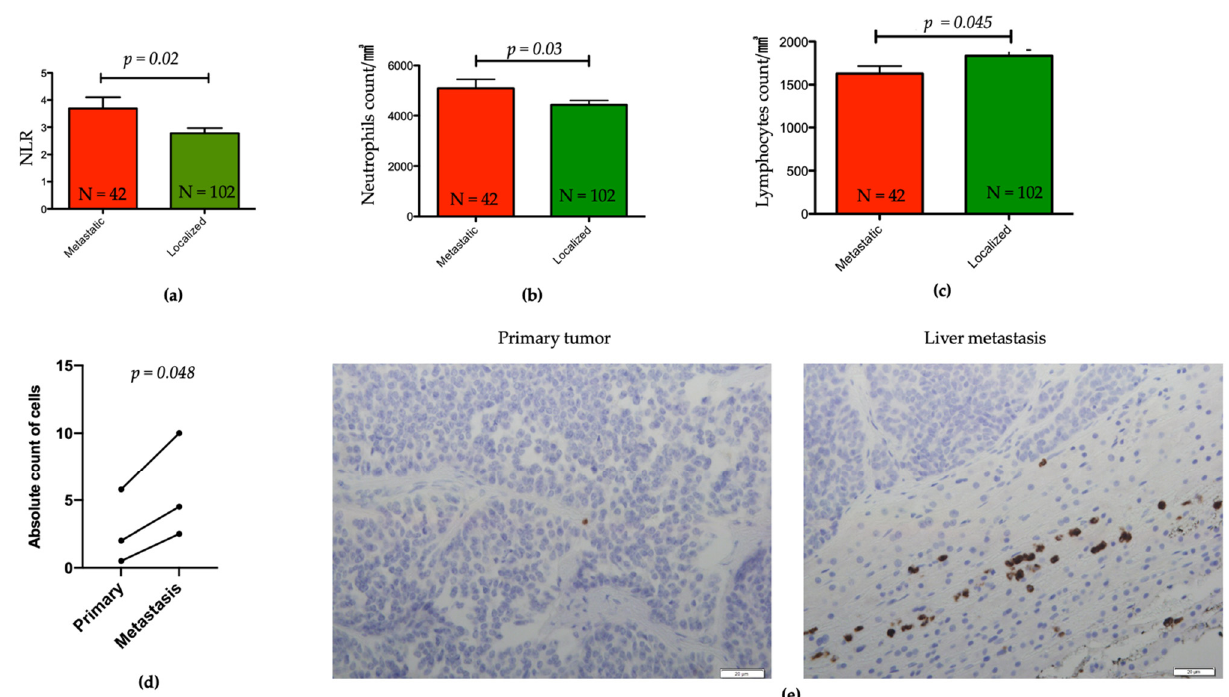
Figure 2. Distribution of patients’ blood neutrophils and lymphocytes counts in pNET. ( a ) Bar plot representing NLR from peripherical blood of patients with metastatic versus localized pNET; Student’s t -test: p = 0.02 . ( b , c ) Bar plot of neutrophils and lymphocytes counts in patients with metastatic versus localized pNET; Student’s t -test: p = 0.03 and p = 0.045 , respec- tively. ( d ) Dot plots representing the tumor-associated neutrophils counts in paired metastatic and in primary pNETs. ( e ) Representation of IHC CD66b staining of tumor-associated neutrophils in a primary pancreatic neuroendocrine tumor (left) and its corresponding liver metastasis (right), x400.